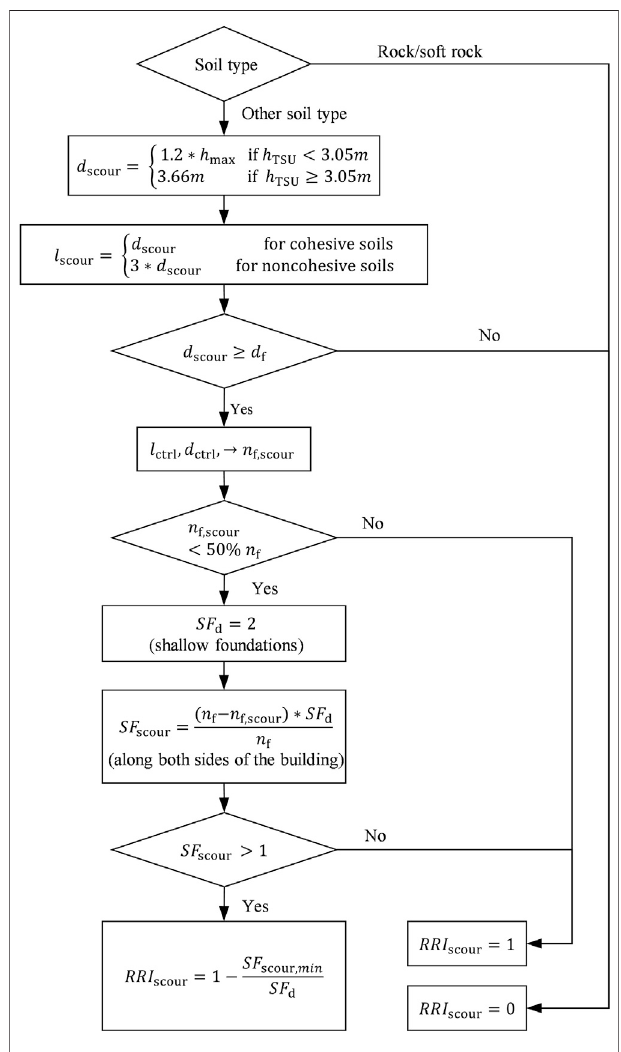
FIGURE 3 | Flowchart for estimating RRI scour